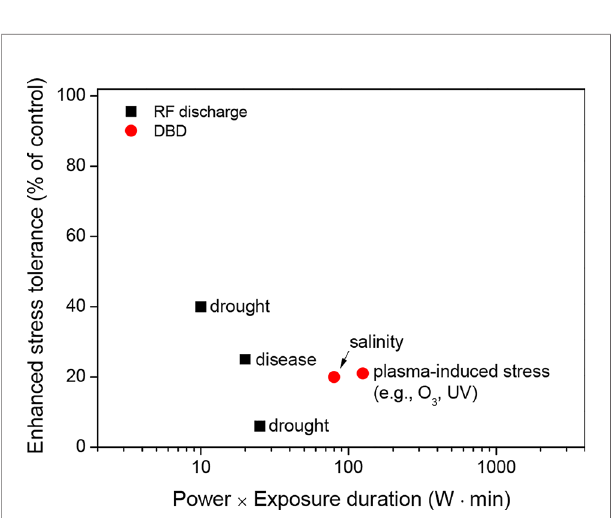
FIGURE 5 | Crop response as a function of power (W) and exposure time (min) of the plasma treatment. The optimal plasma exposure can enhance seed germination and seedling growth before stress events.